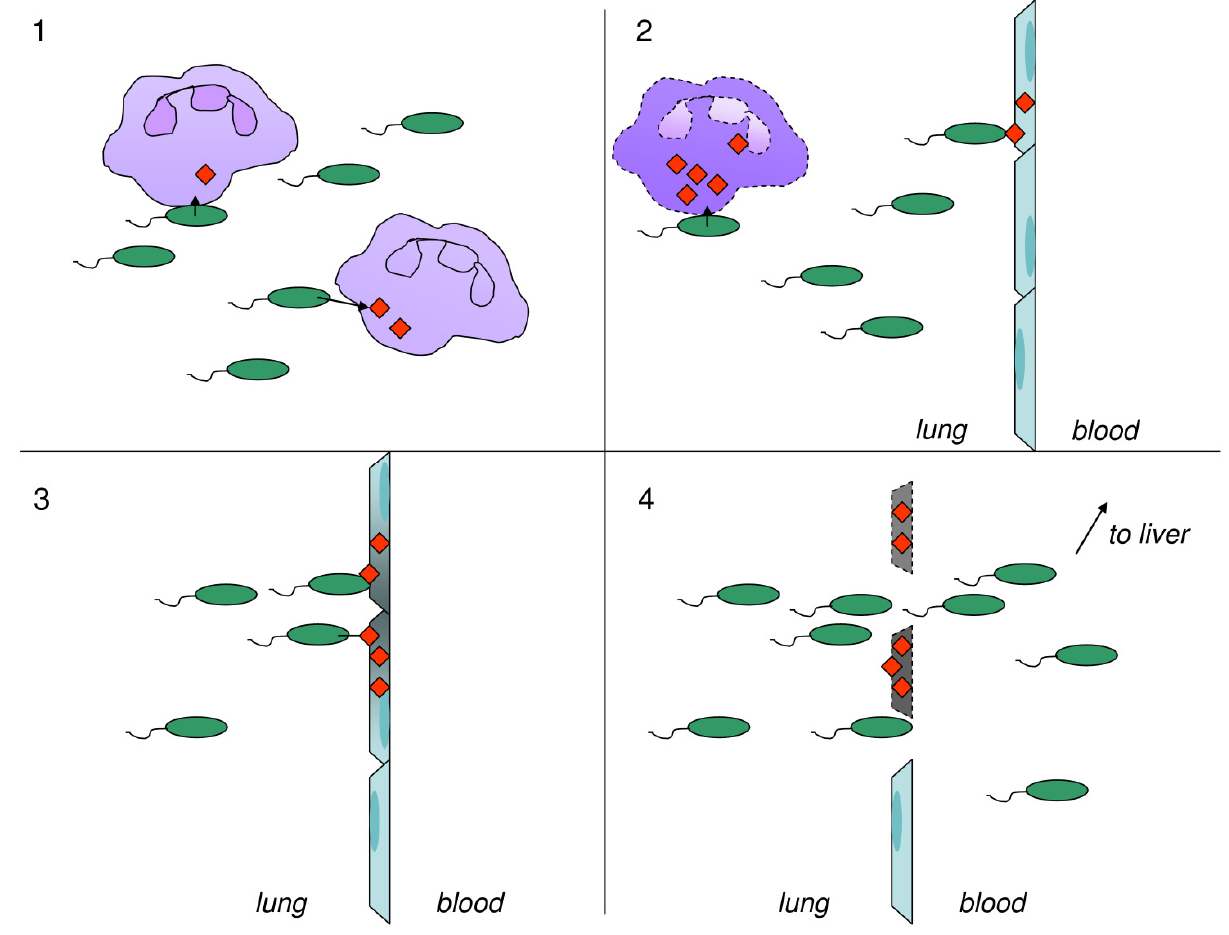
FIGURE 1: Model for ExoS-mediated bacterial dissemination during acute pneumonia. 1. Early during infection, neutrophils (purple) are injected with ExoS (red), preventing phagocytosis and clearance of P. aeruginosa bacteria (green). 2. Later during infection, bacteria encoun- ter the pulmonary-vascular barrier and inject type I pneumocytes (blue) with ExoS. 3. ExoS injection occurs at discrete regions termed FOCI (gray), which expand as infection progresses and type I pneumocytes are killed. 4. Pulmonary-vascular leakage allows bacteria to dissemi- nate into the bloodstream and to the